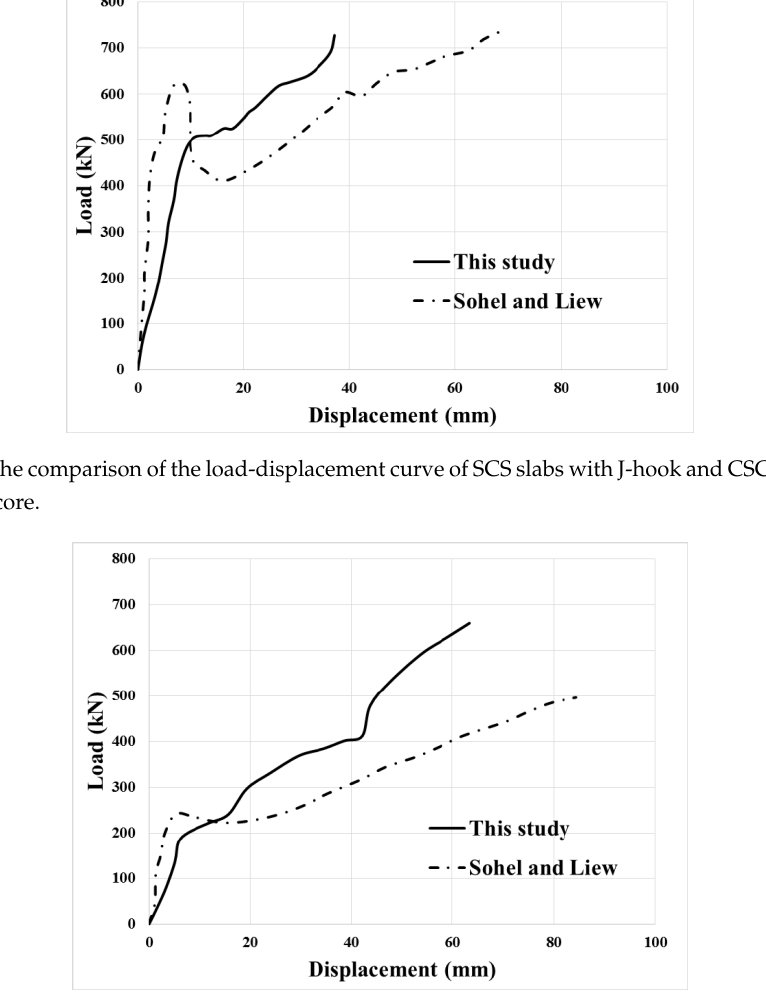
Figure 16. The comparison of the load-displacement curve of SCS slabs with J- hook and CSC connectors with LWC.